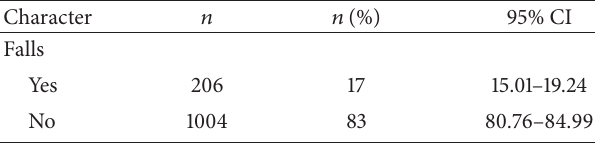
Table 1: Prevalence of falls among 1210 elderly with dementia.